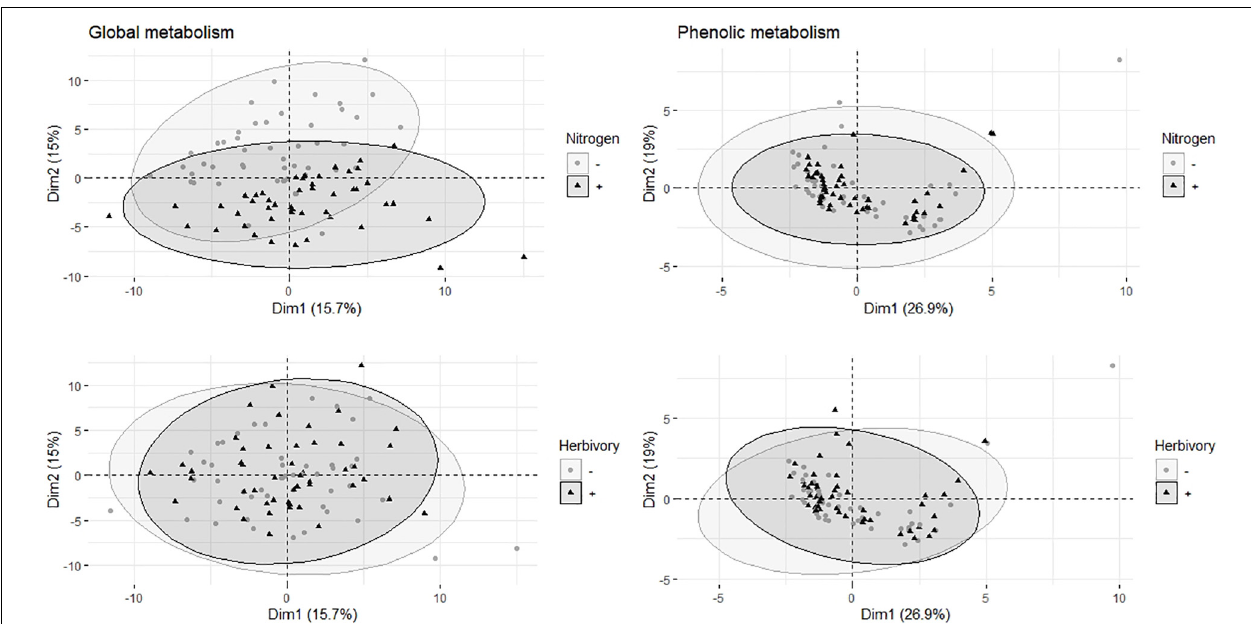
FIGURE 1 | Multivariate analyses of metabolites in the leaves of aspen ( Populus tremula ) plants exposed to environmental endophytic inoculum in controlled, greenhouse conditions: untreated control plants (C) and plants subjected to nitrogen addition (N), herbivory (H), or nitrogen addition and herbivory in combination (NH) ( n = 24 plants per treatment). Shown are the principal component analysis score plots of 114 targeted and non-targeted foliar metabolites (global analysis, data acquired using gas chromatography/mass spectrometry) and 11 targeted metabolites (the main salicinoid phenolic glycosides and catechin; data acquired using liquid